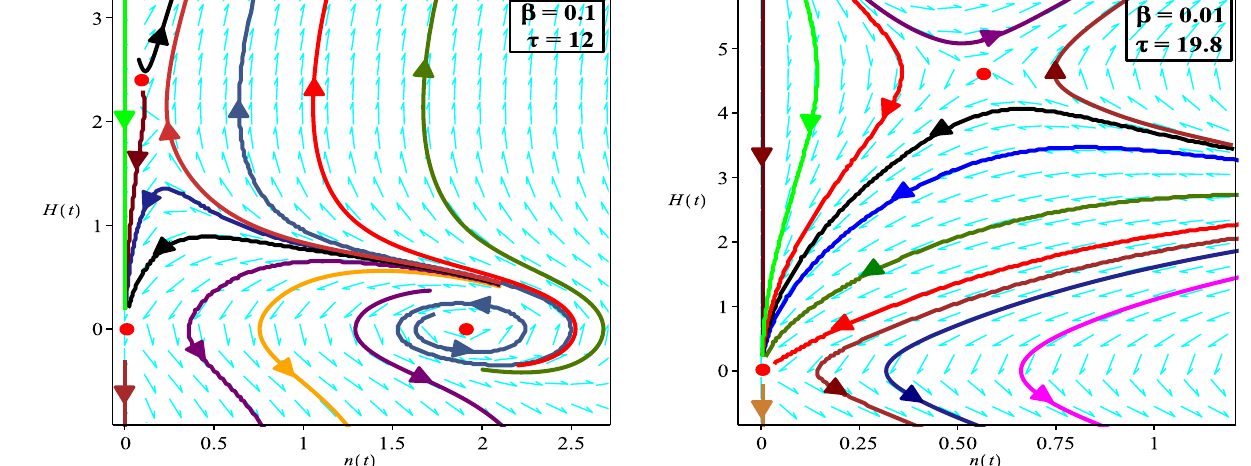
Fig. 7 Parts a and b : the case of α = 4 – some representative cases. Parts c and d : the case of α = 4 – some representative